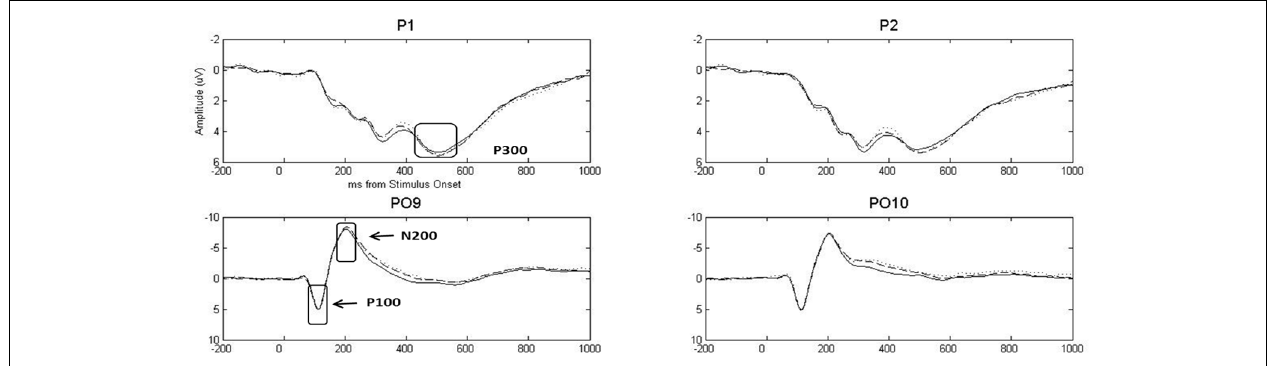
FIGURE 1 | Grand-average event-related potential waveforms for representative posterior sensors, highlighting P100, N200, and P300. Dotted, solid, and dashed lines represent pleasant, neutral, and unpleasant stimuli, respectively. Stimulus onset was at time = 0 ms.